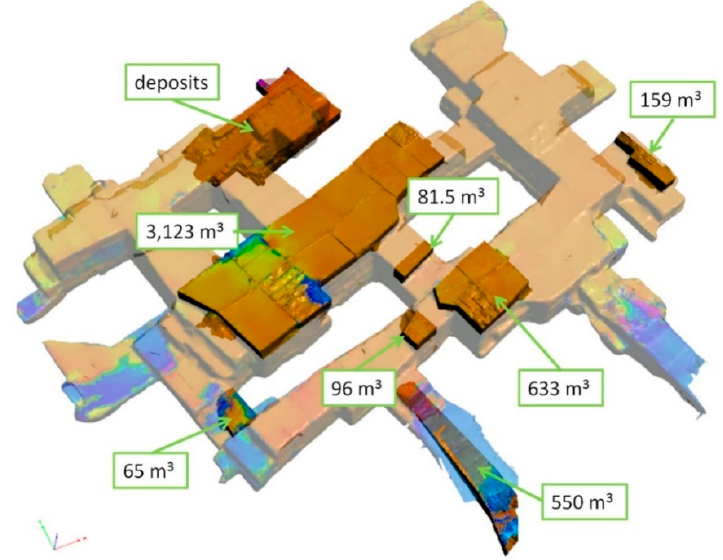
Figure 10. Overall Piastreta 3D model with highlighted the single representations of extracted marble blocks (individual volumes are expressed in m 3 ).